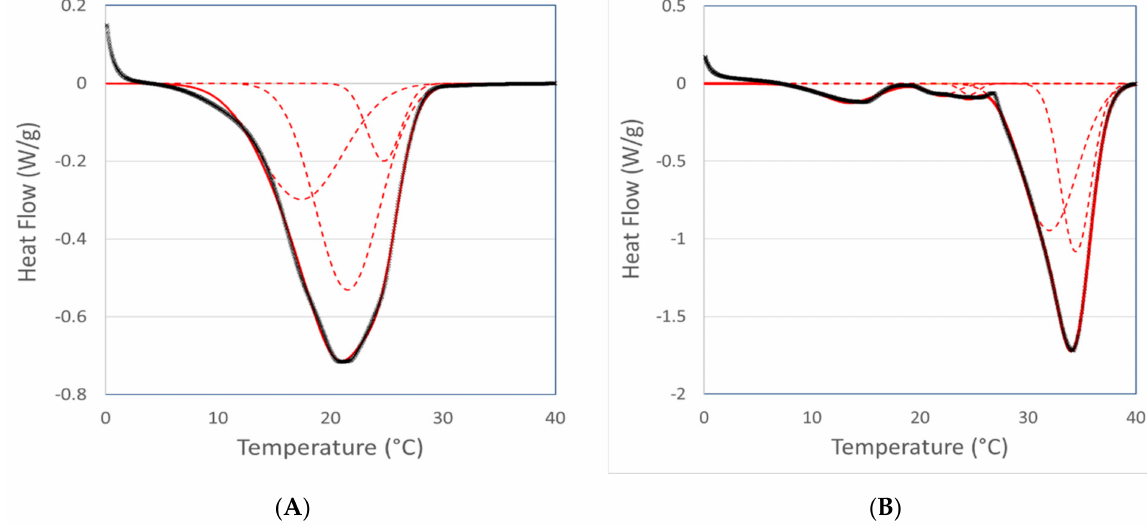
Figure 3. Deconvolution of the DSC melting profiles (endo down) of non-tempered ( A ) and tempered ( B ) cocoa butter incubated at 0 ◦ C: the dotted lines show the different Gaussian contributions to the overall DSC profile (which is shown by the full